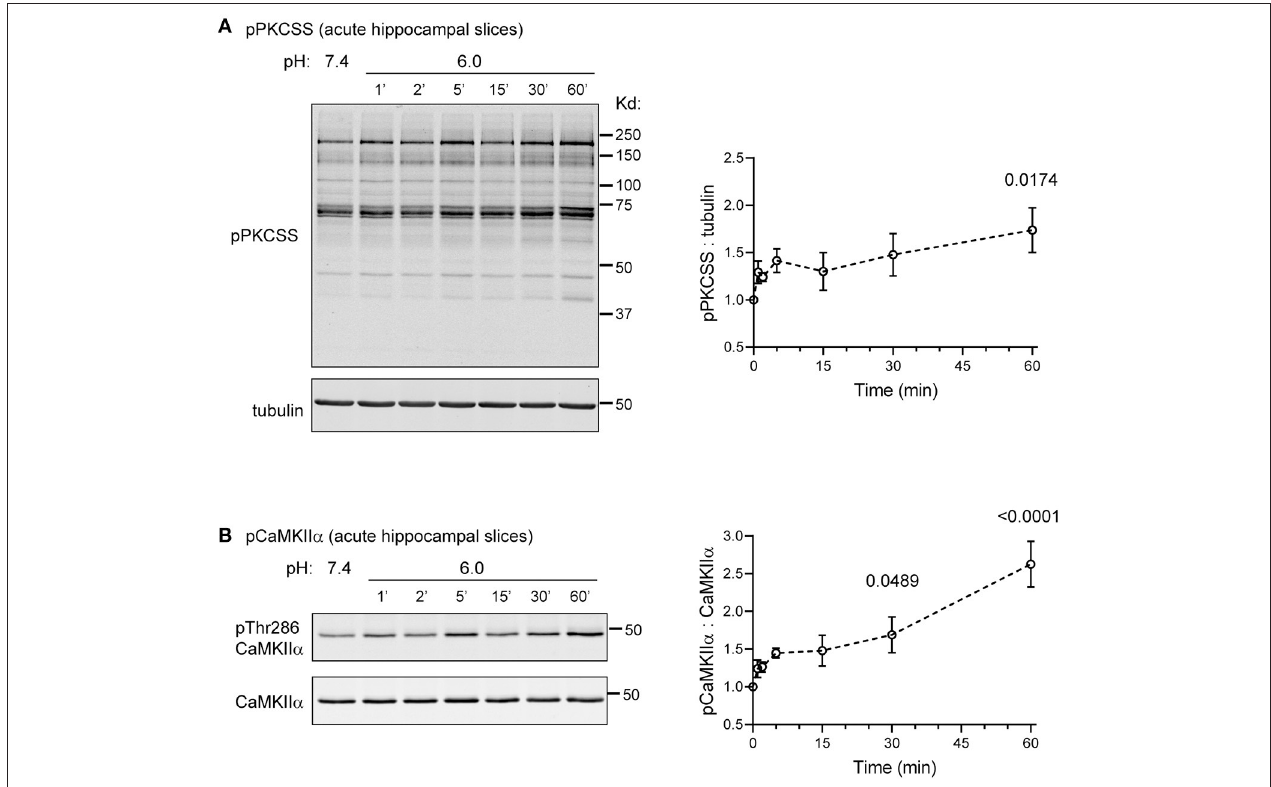
FIGURE 7 | Acidosis-induced pPKCSS and pCaMKII α changes in acute hippocampal slices. Representative Western blot and quantification of pH 6-induced pPKCSS (A) and pCaMKII α (B) signals in hippocampal slices acutely isolated from young adult mice. Acute slices were prepared from 7 to 9 week old WT male mice as described in Methods. Following recovery in ACSF, the slices were treated with pH 6 for the indicated time, lysed, and blotted for the antibodies indicated. Each animal generated enough slices for the entire time course. Summary plot was from 4 animals. Each data point was compared with pH 7.4 (the “0” time point on graph) (1-way Anova with Dunnett’s post-hoc correction). For time points exhibited significant differences, the actual p -value was reported on the